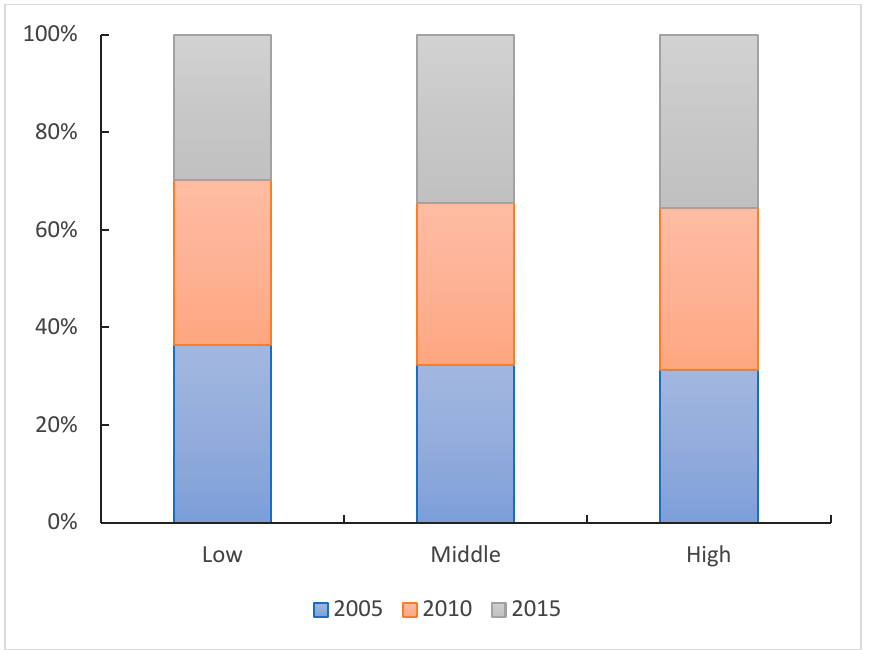
Figure 6. The area of each level of FVC in 2005, 2010 and 2015.